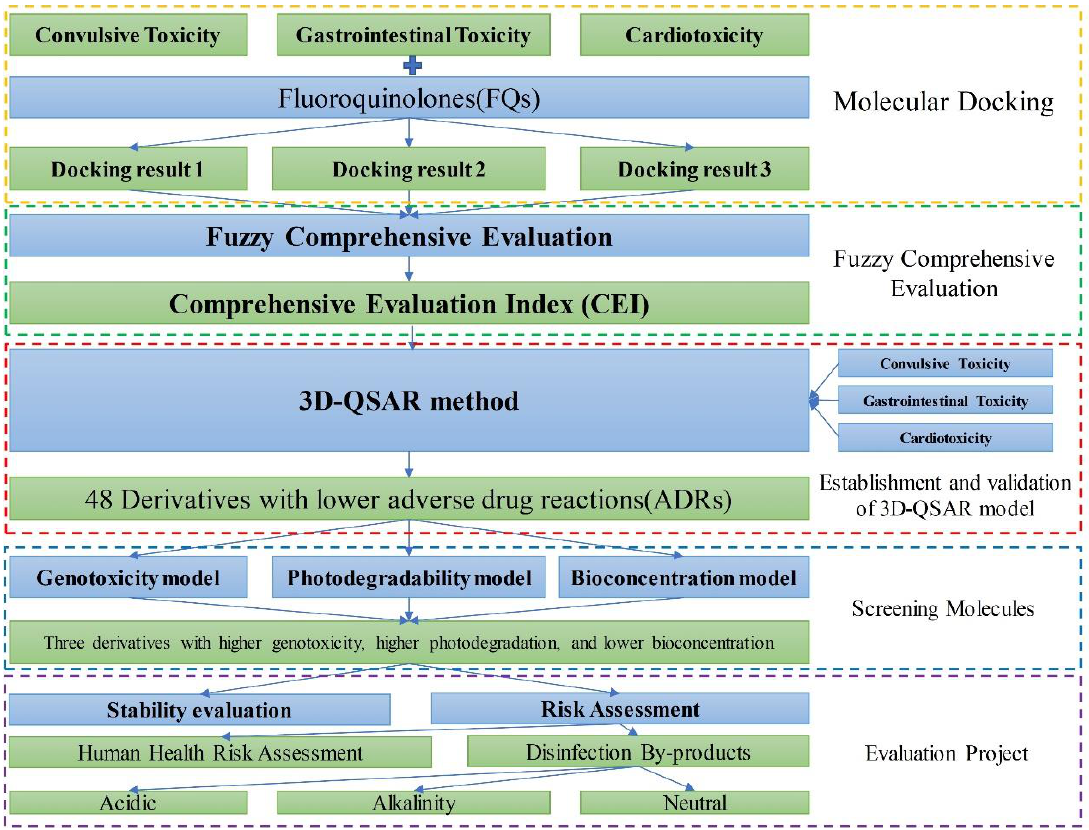
Figure 3. Workflow chart.